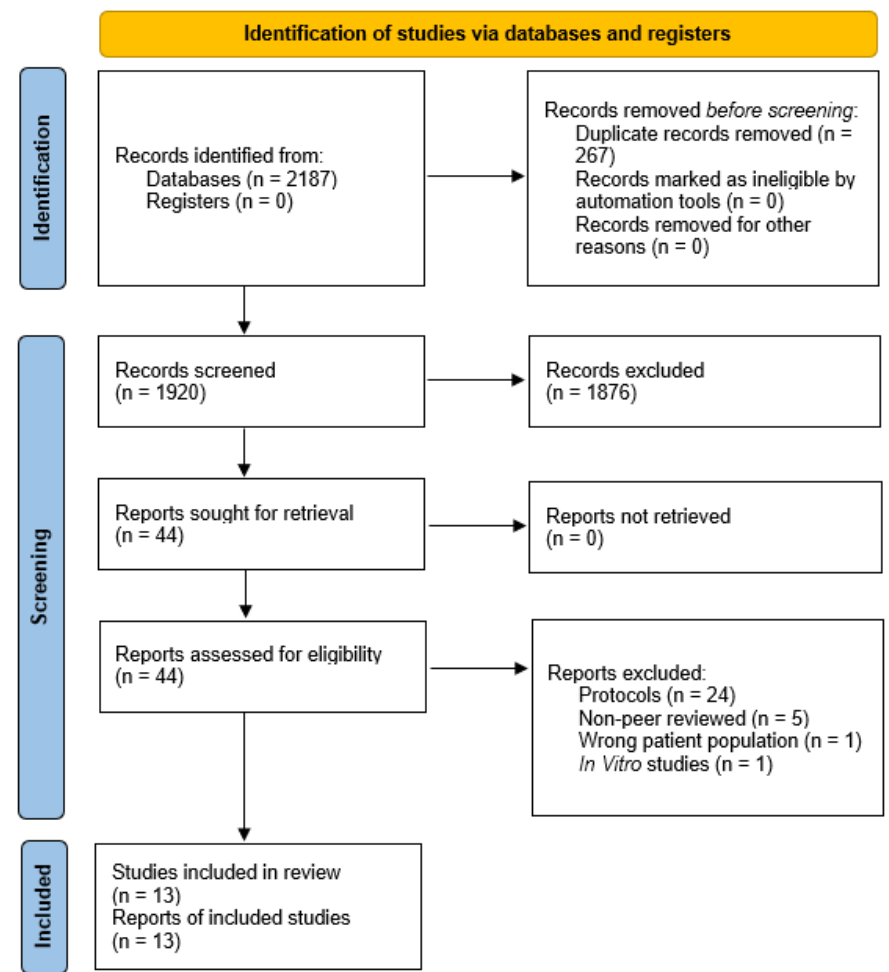
Figure 1. Flow diagram for identification of studies in the systematic review.